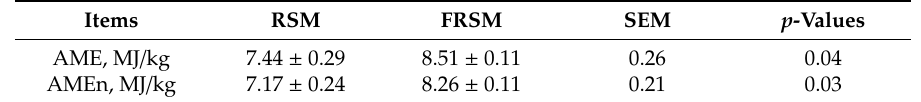
Table 5. Metabolizable and nitrogen corrected metabolizable energy of RSM and FRSM (dry matter